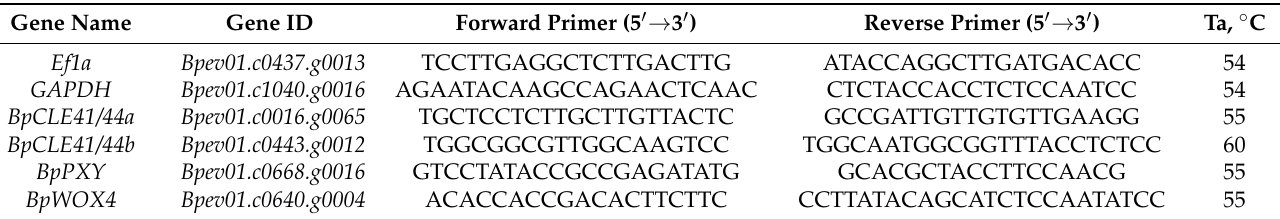
Table 5. The list of primers for the RT-PCR